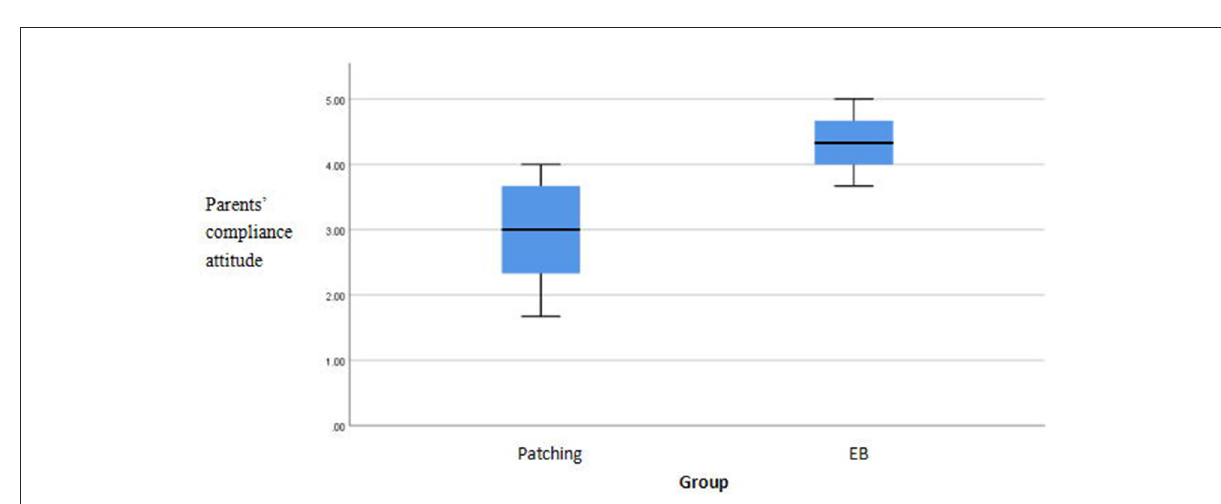
FIGURE7 Box plots of parents’ compliance attitude on two training methods. EB,